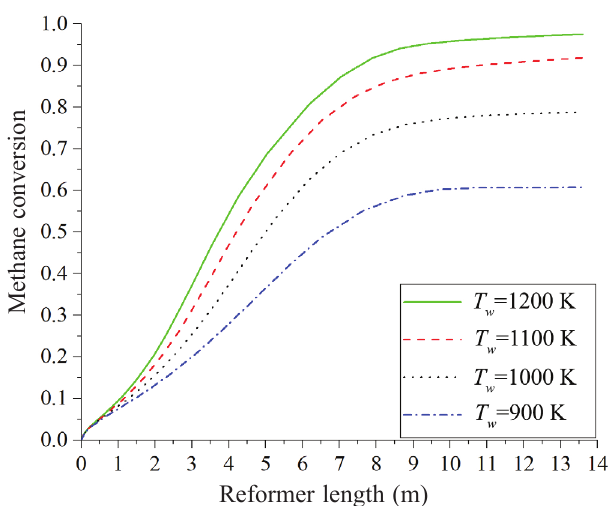
Fig. 3 – Tube wall temperature effect on methane conversion